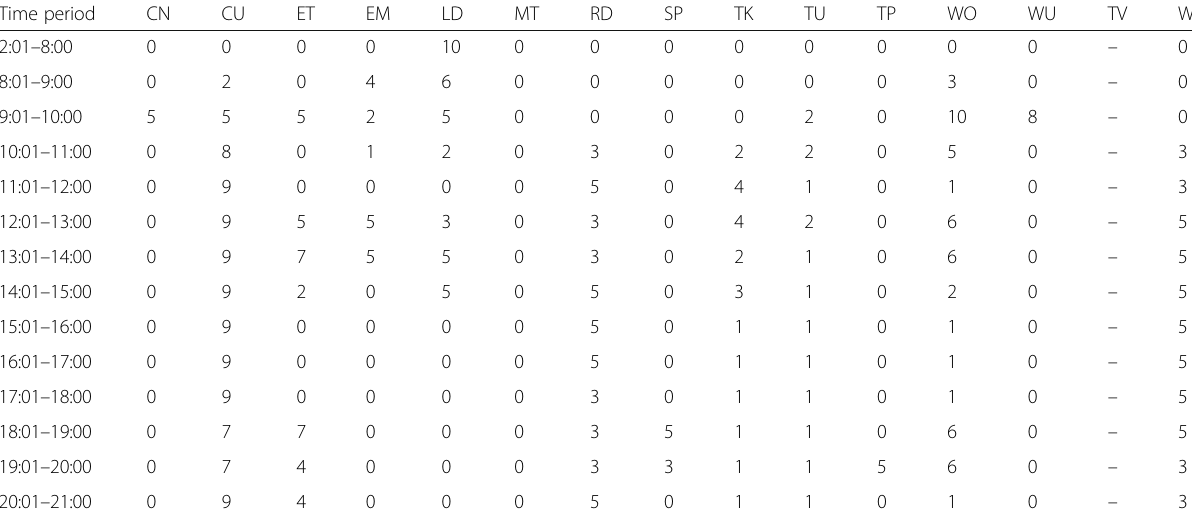
Table 18 Time – activity table for Saturday for eButton wearer